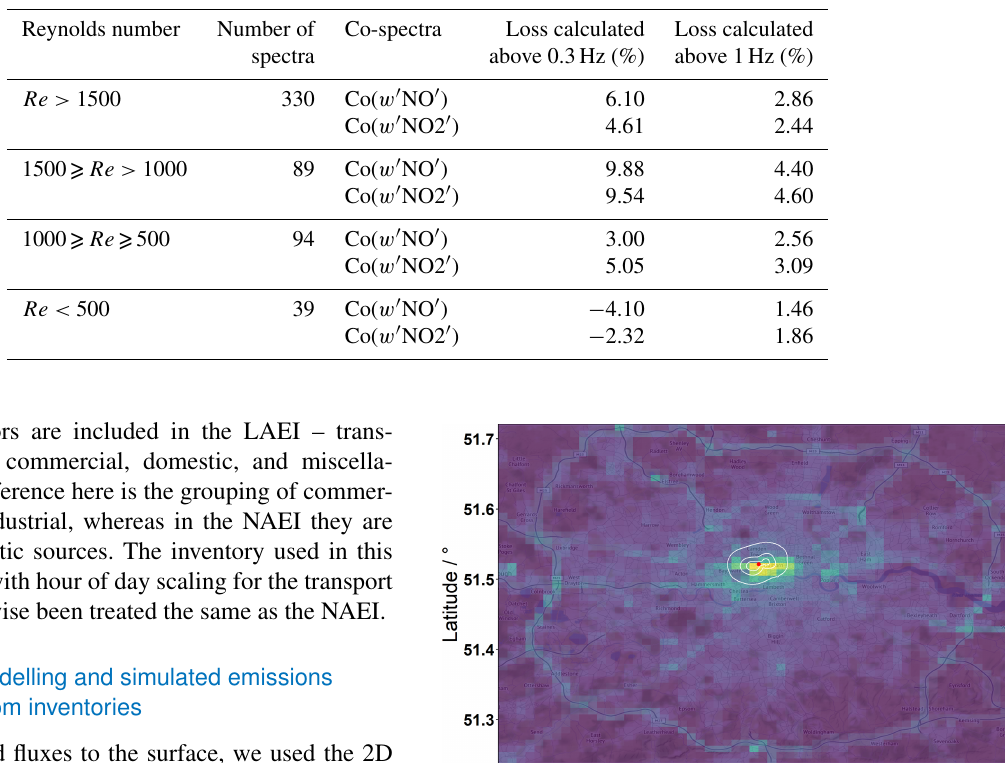
Table 1. High-frequency corrections derived for four sample line regimes using 0.3 and 1Hz for the thresholds above which the correction was calculated.